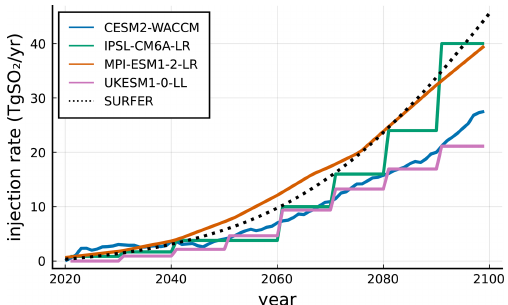
Figure 18. Comparison of SO 2 injection rate needed to do the G6sulfur experiment by SURFER and by ESMs participating in Ge- oMIP reported in Visioni et al.